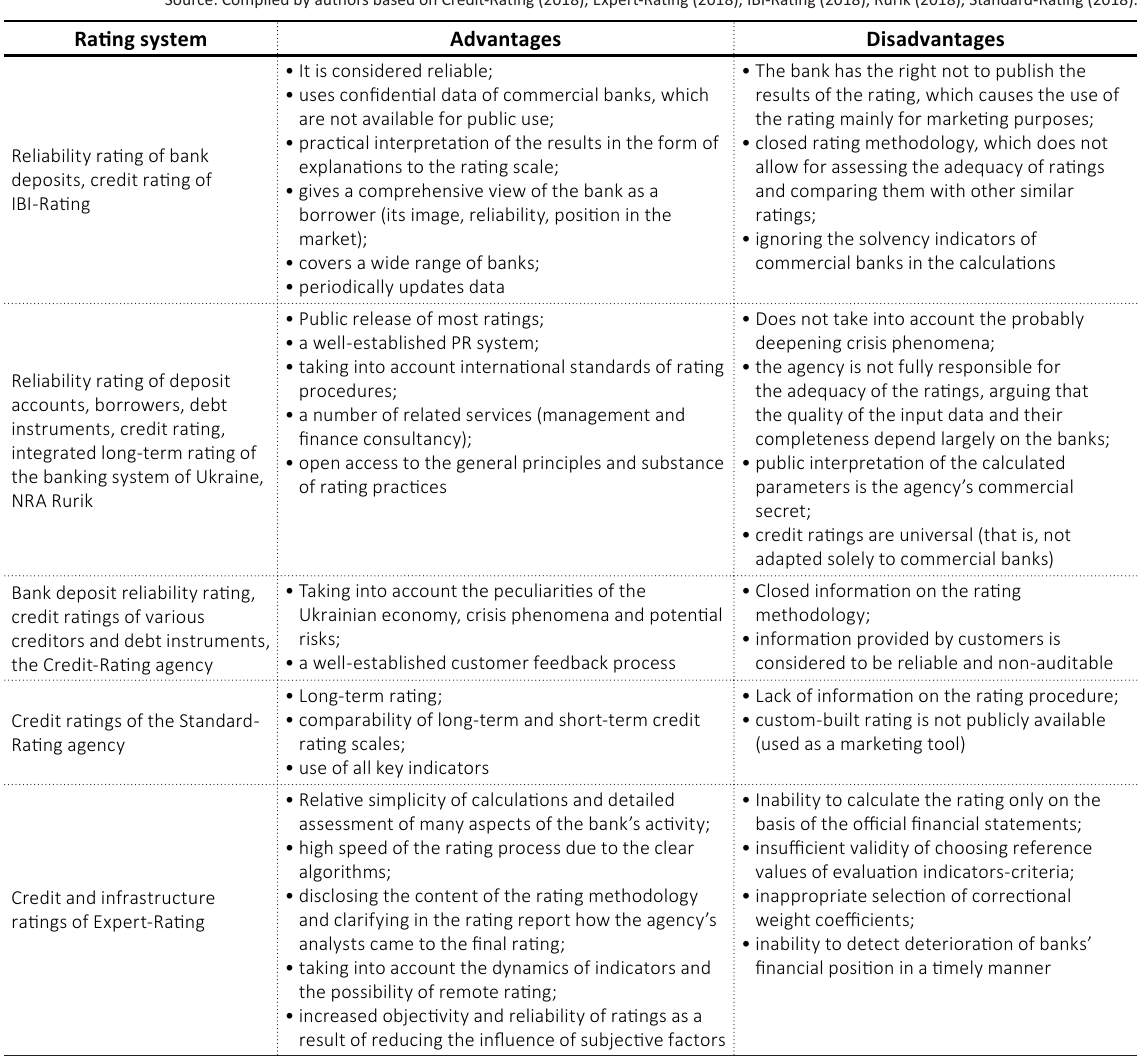
Table 1. Advantages and disadvantages of rating systems for evaluating the performance of commercial banks in